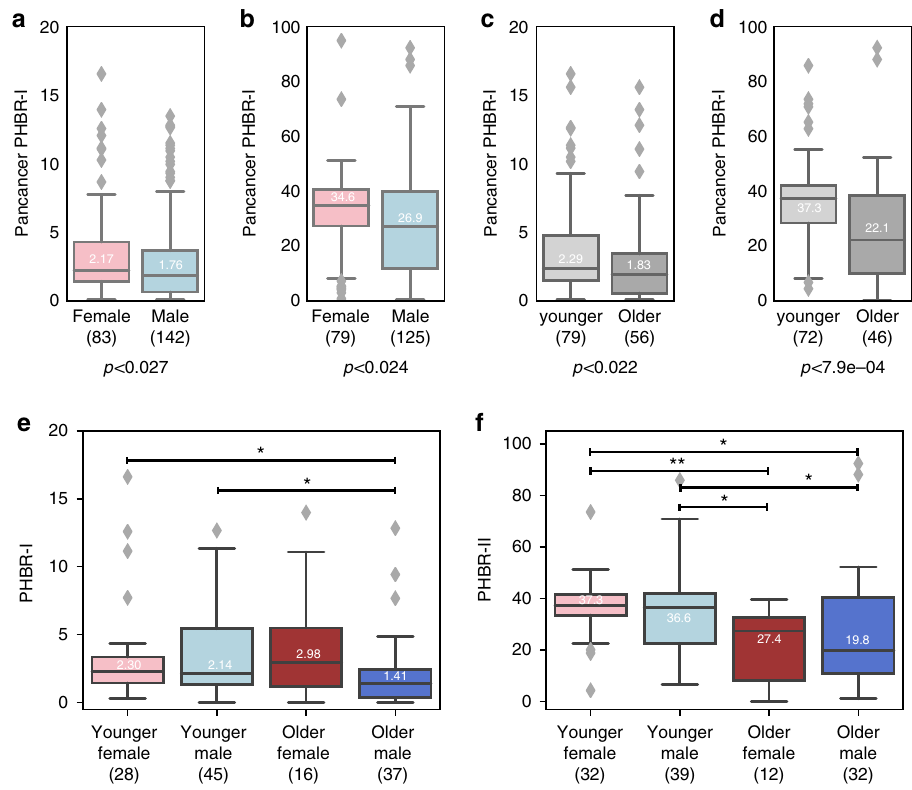
Fig. 4 Sex- and age-speci fi c MHC presentation of observed driver mutations in the validation cohort. a , b Box plots denoting the distribution of ( a ) PHBR- I and ( b ) PHBR-II scores for driver mutations in female and male pan-cancer patients. Exact p values were calculated using a one-tailed Mann – Whitney U test: ( a ) 0.027 and ( b ) 0.024, and effect sizes were calculated using Cliff ’ s d: ( a ) r = − 0.154, ( b ) r = − 0.164. c , d Box plots denoting the distribution of ( c ) PHBR-I and ( d ) PHBR-II scores for driver mutations in younger and older pan-cancer patients. Exact p values were calculated using a one-tailed Mann – Whitney U test: ( c ) 0.022 and ( d ) 7.9e − 04, and effect sizes were calculated using Cliff ’ s d: ( c ) r = − 0.207, ( d ) − 0.346. e , f Box plots denoting the distribution of ( e ) PHBR-I and ( f ) PHBR-II scores for driver mutations among integrated sex- and age-speci fi c pan-cancer patient cohorts. One asterisk indicates p values <0.05 and two asterisks indicates p values<0.001. P values were calculated using a one-tailed Mann – Whitney U test. The Benjamini – Hochberg method was used to adjust for multiple comparisons for ( e , f ). Median values are shown in each boxplot. Exact p values for ( e ) include: YM, OM: 0.024; YF, OM: 0.028; OF, OM: 0.070; YF, OF: 0.56; YF, YM: 0.49; OF, YM: 0.50. Exact p values for ( f ) include: YF, OF: 0.0083; YF, OM: 0.013; OF, YM: 0.023; YM, OM: 0.045; YF, YM: 0.24; OF, OM: 0.34. Y = younger, O = older, F = female, M = male. All box plots include the median line, the box denotes the interquartile range (IQR), whiskers denote the rest of the data distribution and outliers are denoted by points greater than